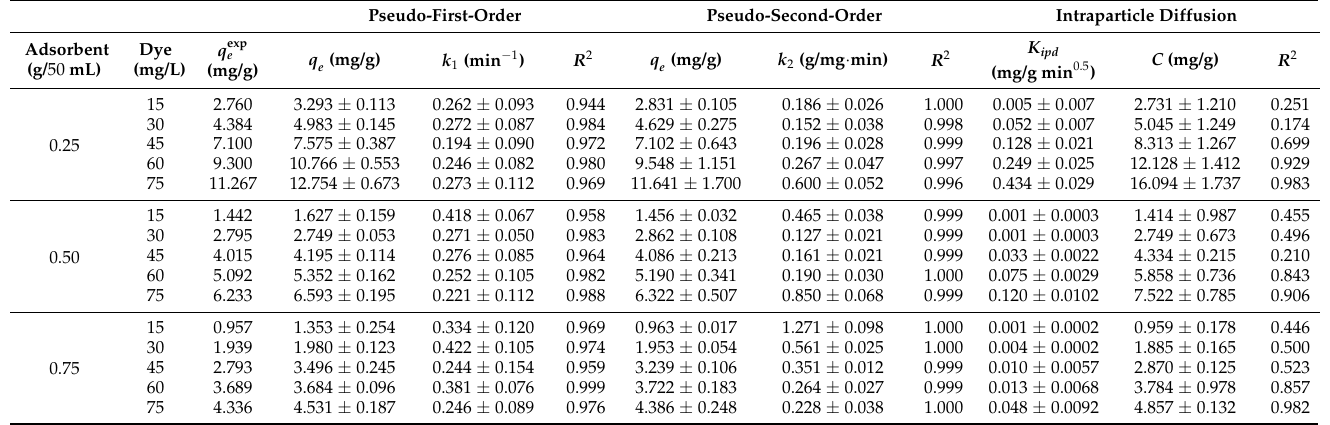
Table 7. Results of the kinetic models considered for CNB—Basic Navy Blue Dye 2RN.